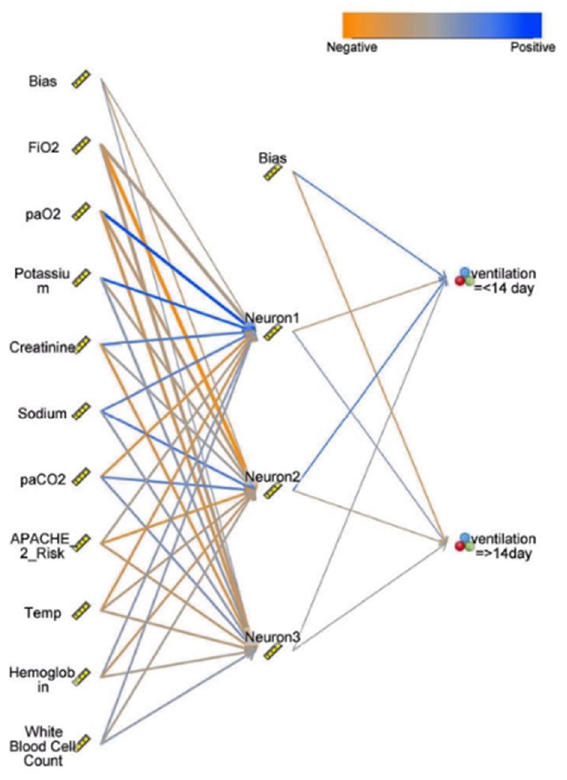
Figure 5. Schematic of the artificial neural network (ANN) constructed here. 50 input variables were